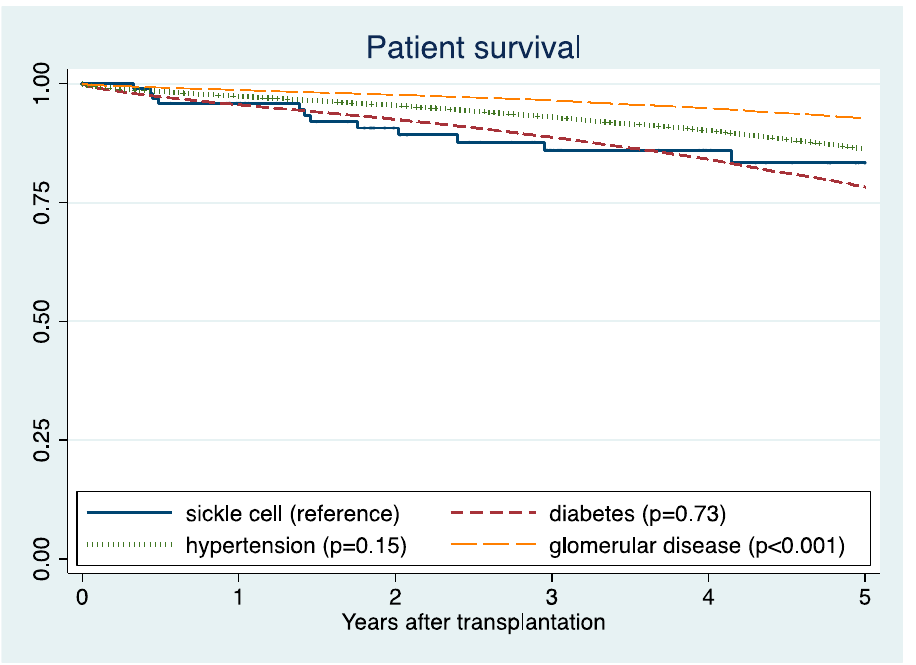
Figure 4. Patients survival according to the causes of end-stage kidney disease.